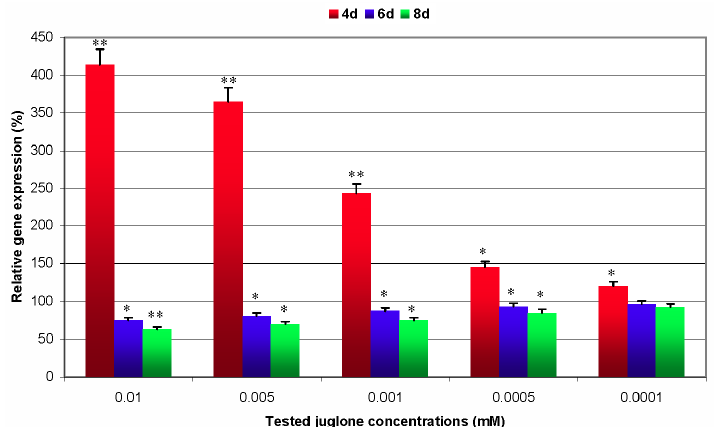
Figure 5. Transcript levels of GstI gene in primary roots of maize seedlings affected by juglone treatment. 100%—the reference level of gene expression in untreated maize seedlings; * p < 0.05; ** p < 0.01 (Student’s t -test) —significant differences in relative gene expression between the tested treatment group and the control group of